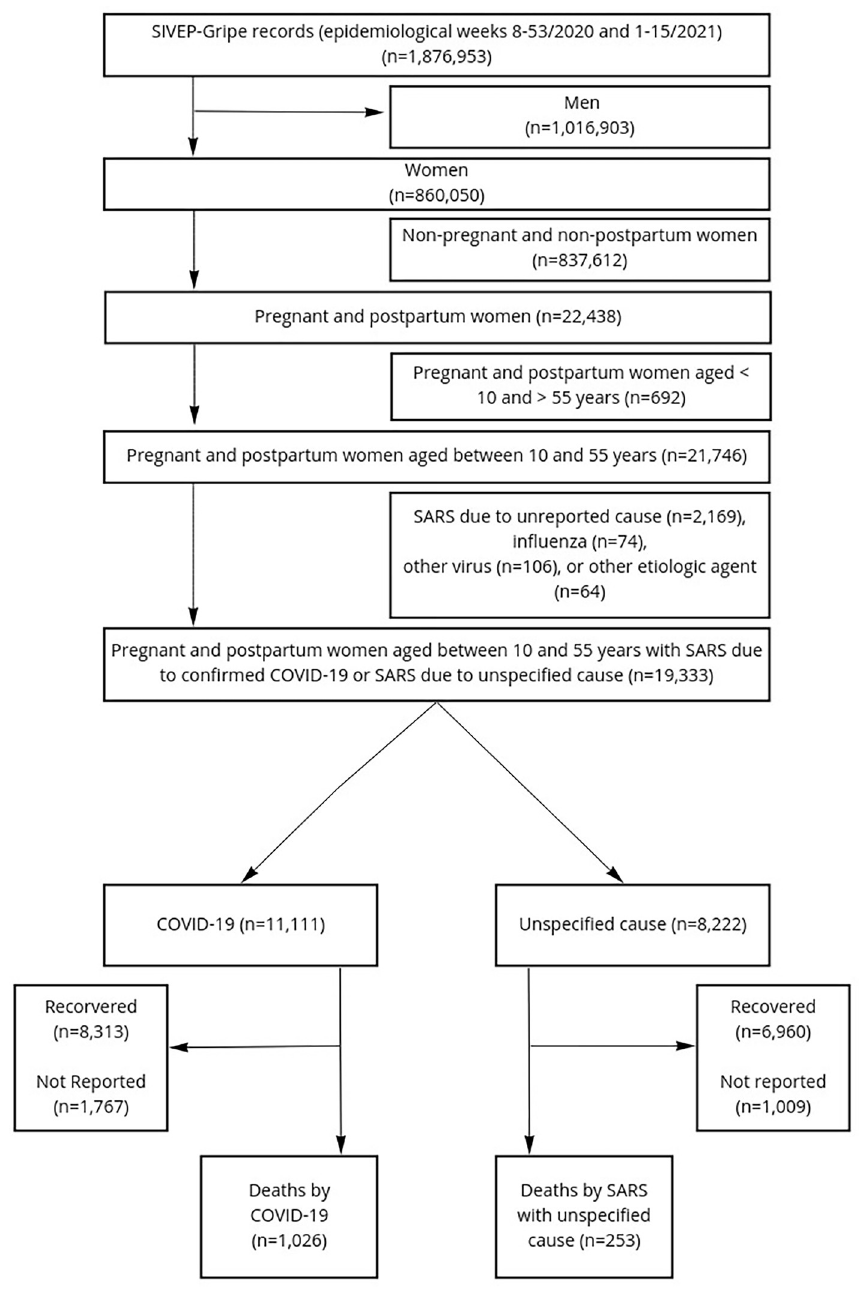
Fig 1. Case selection